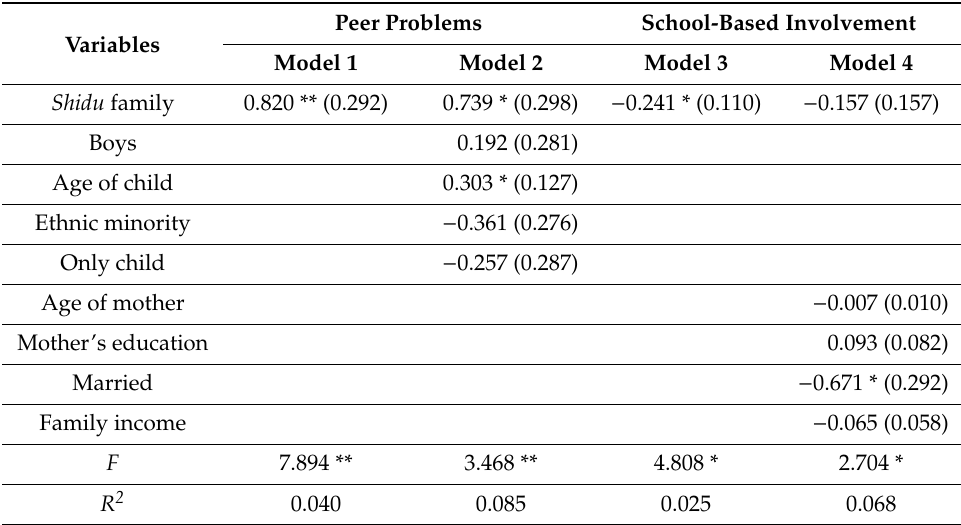
Table 3. Unadjusted and adjusted linear regression analyses for children’s peer problems and maternal school-based involvement ( n = 192).